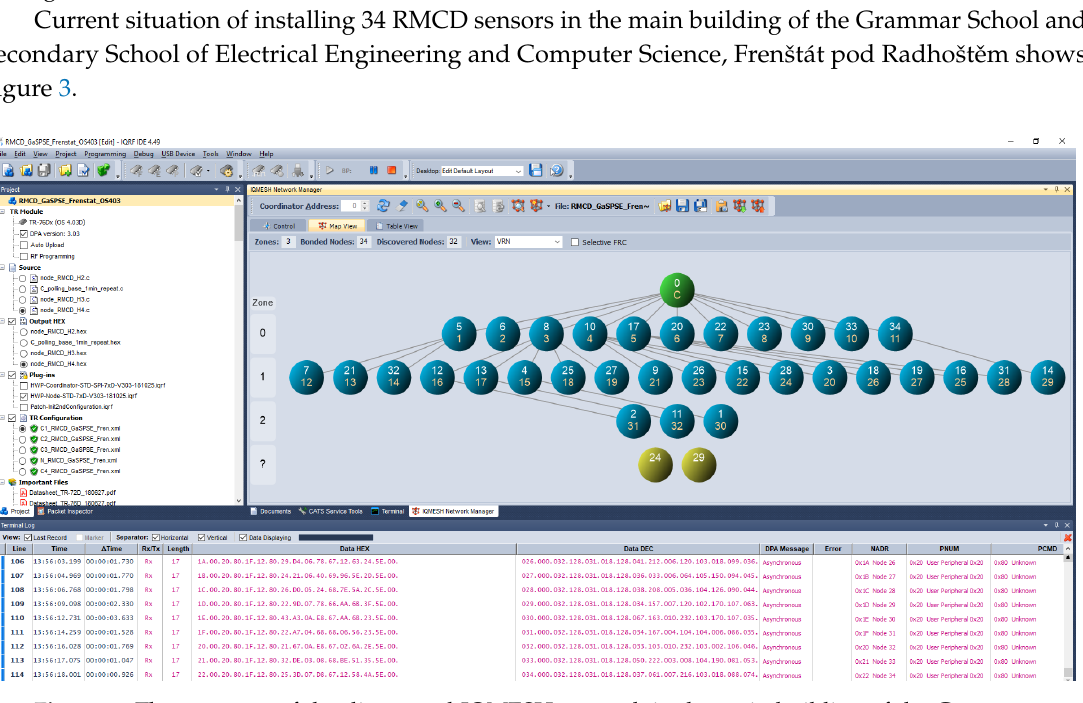
Figure 3. The structure of the discovered IQMESH network in the main building of the Grammar School and Secondary School of Electrical Engineering and Computer Science, Frenštát pod